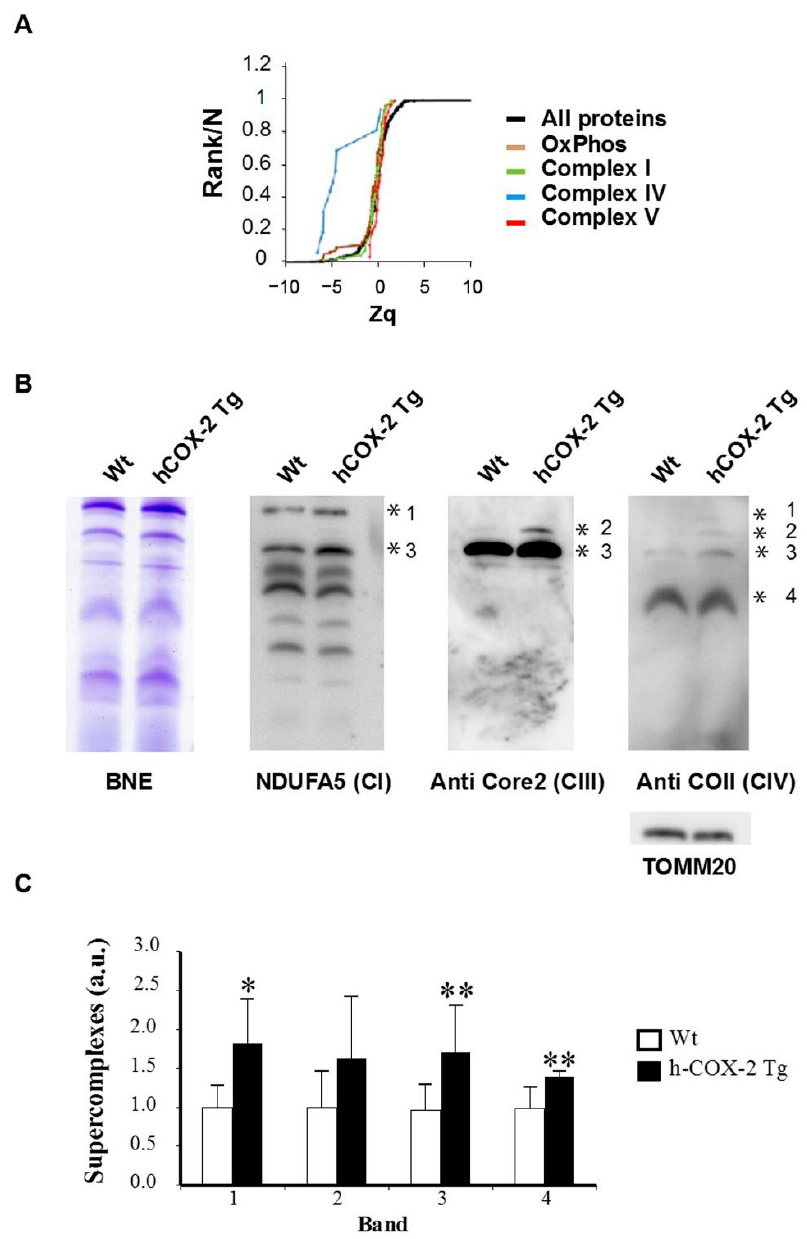
Figure 7. Analysis of mitochondrial supercomplex components. ( A ) Cumulative distributions of the standardized variable at the protein level (i.e., corrected log 2 ratios of proteins expressed in standard deviation units), for all OxPhos proteins or those belonging to Complex I, III, IV and V. The black sigmoid is the theoretical null hypothesis distribution; a shift to the left indicates an increase in protein abundance in hCOX2 Tg mice. ( B ) Representative image of the detection of the respiratory complexes and potential supercomplexes after blue native gel electrophoresis analysis from digitonin solubilized mitochondria from Wt and h-COX-2 Tg mice hearts, followed by Western blot analysis using sequentially specific antibodies against complexes I, III, and IV. ( C ) Densitometric analysis of the expression of complexes. Data were normalized by calculating the ratios of complexes and TOMM20 band densities, expressed in arbitrary units. Data represent the mean values ± SD. * p < 0.05; ** p < 0.01 hCOX-2 Tg mice vs. Wt .